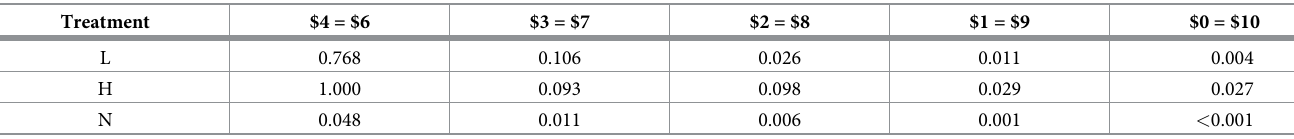
Table 6. Two-sided Fisher test p -values.